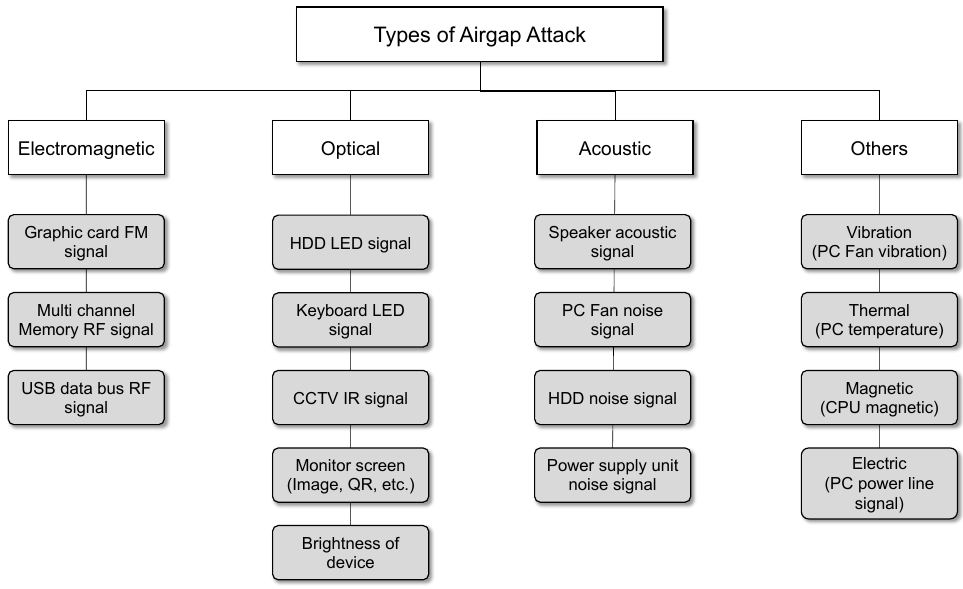
Figure 2. Classification of four air-gap attack types (Electromagnetic, Optical, Acoustic and